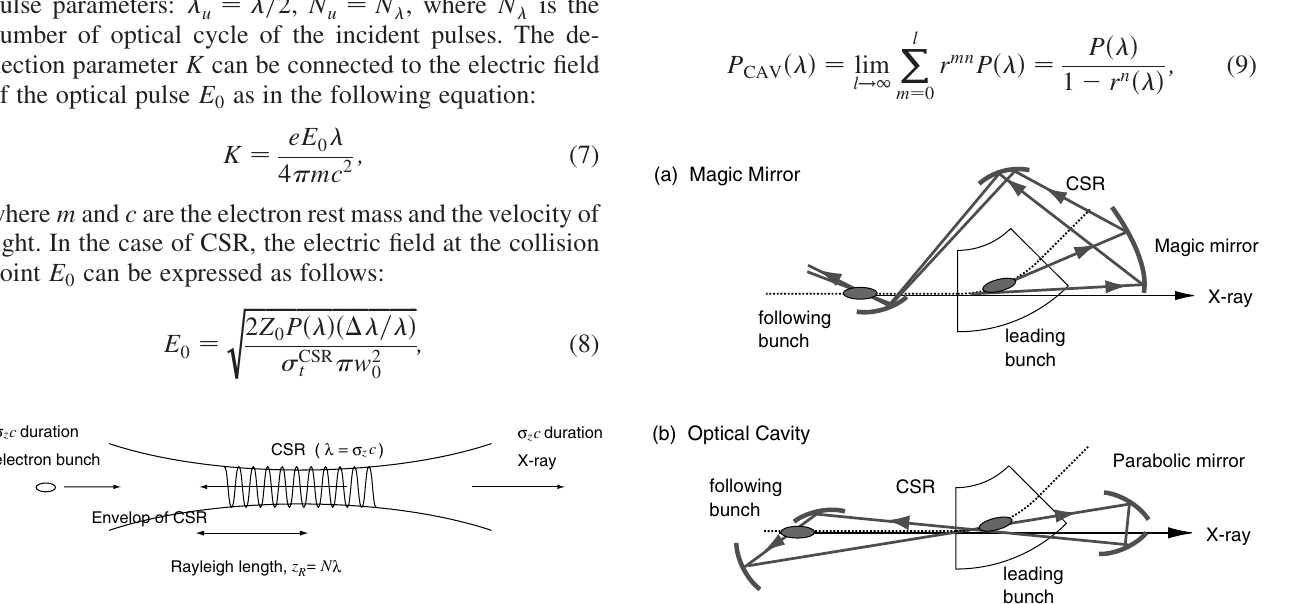
FIG. 1. Schematic drawing of the electron bunch and the laser envelop in inverse Compton scattering of coherent synchrotron radiation with a finite bandwidth.